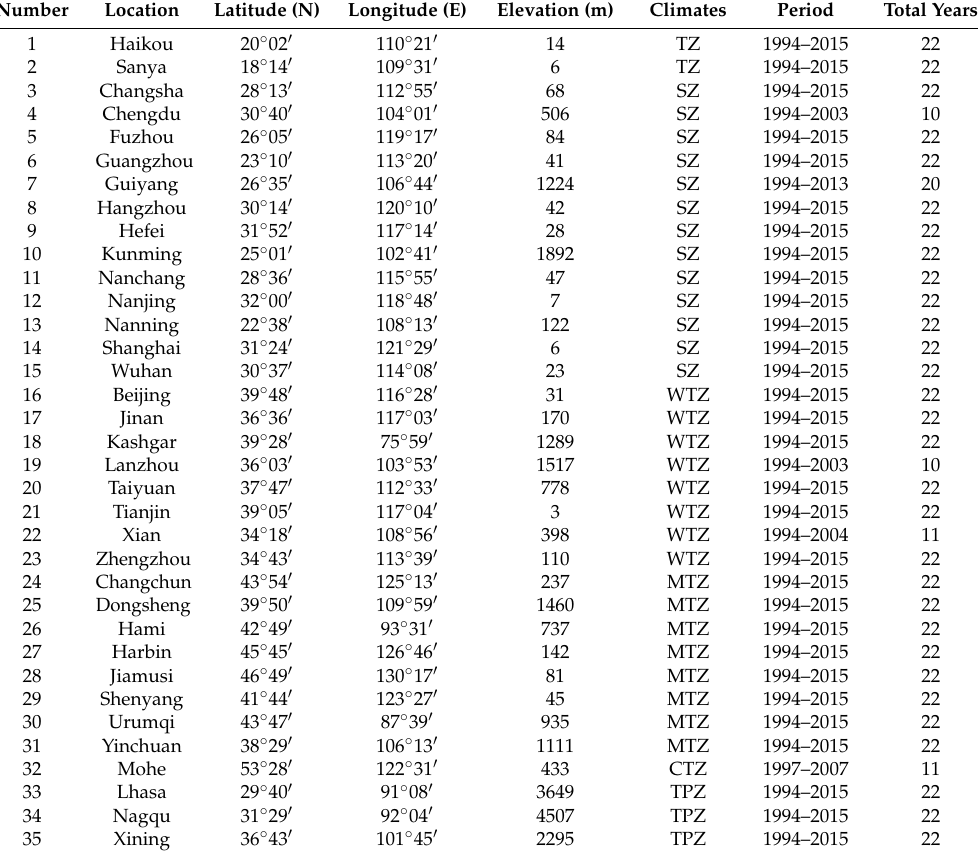
Figure 1. A general layout of the six major climates across China. TZ = Tropical Zone; SZ = Subtropical Zone; WTZ = Warm Temperate Zone; MTZ = Mid Temperate Zone; CTZ = Cold Temperate Zone; PZ = Tibetan Plateau Zone [1]. Table 1. The main information of the 35 cities selected for the present study.